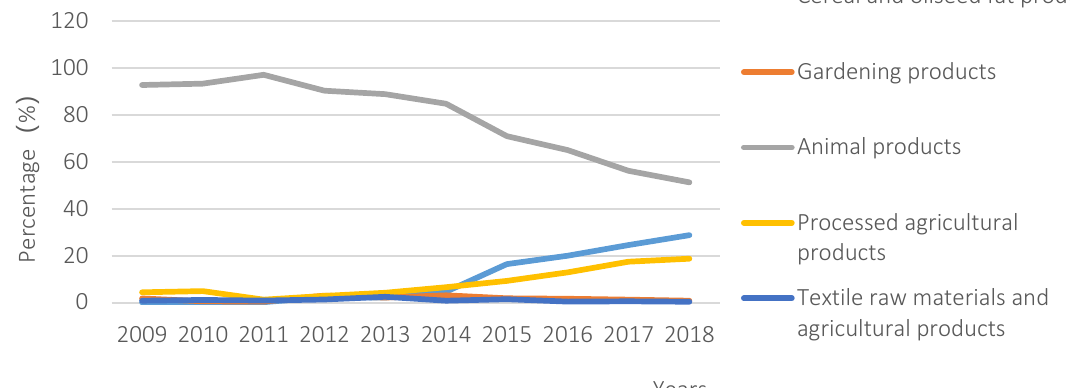
Figure 3. The proportion of Russia’s exports of various agricultural products to China